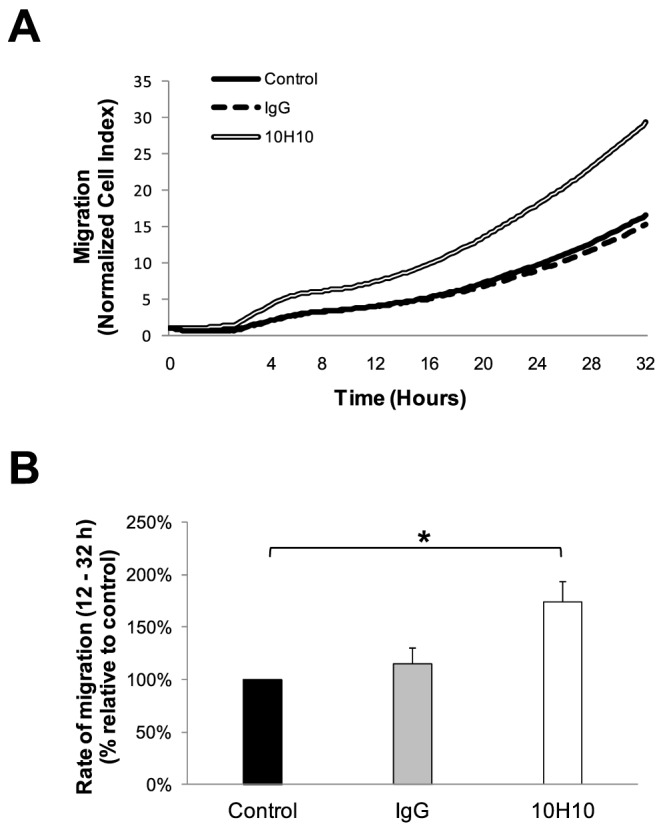
Enhancement of trophoblast migration by mAb 10H10.(A) Representative cell index curves of HTR8 cells for migration in the absence or presence of 10H10 or control mAb (5 µg/ml) measured with xCELLigence system. (B) Exogenous addition of mAb 10H10 (5 µg/ml) significantly increased HTR8 cell migration at 12–32 hours, compared to untreated controls. Data are mean ± SEM from 3 independent experiments, *, P<0.05.